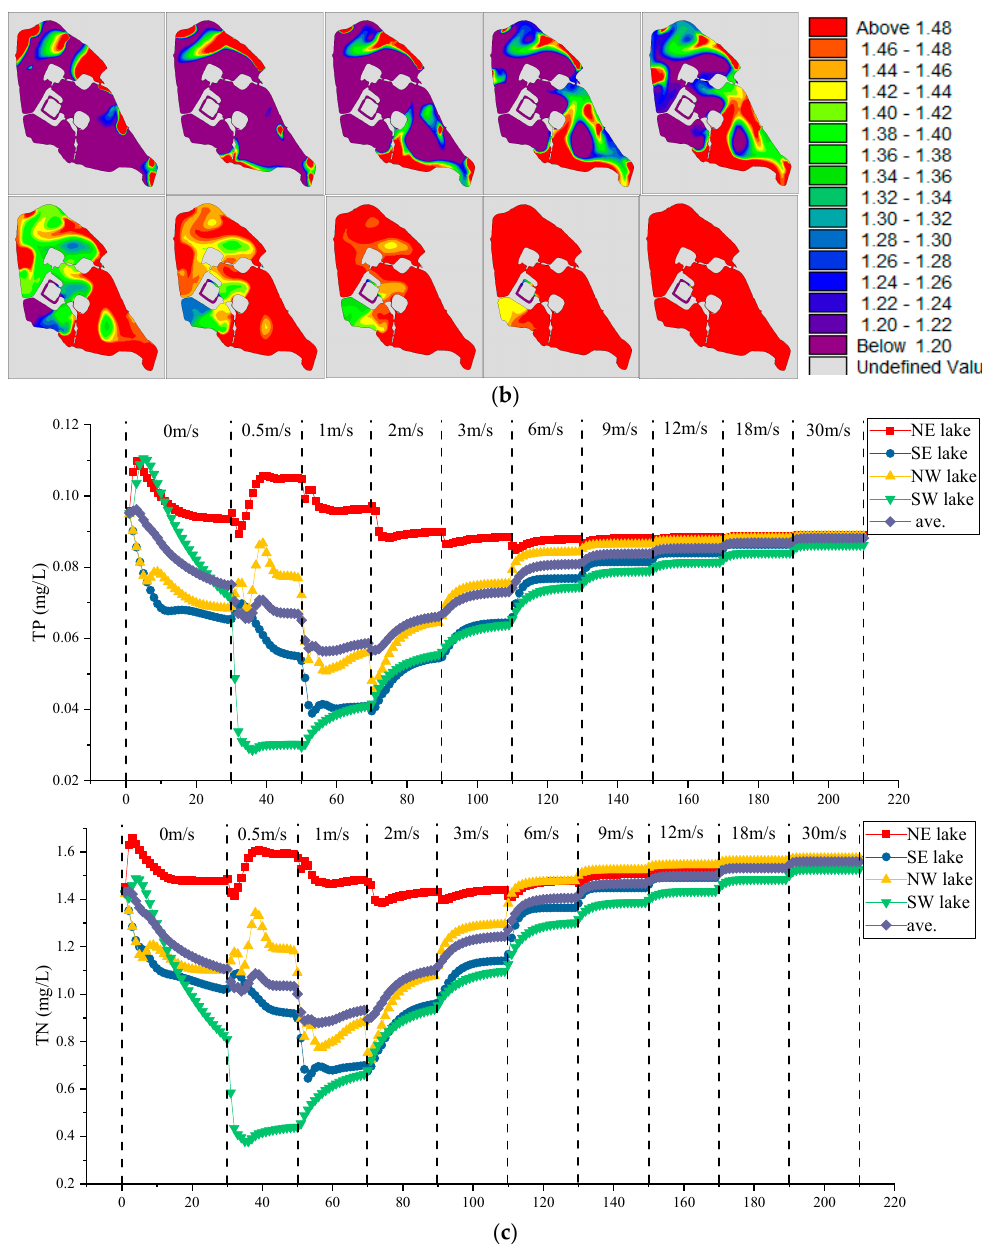
Figure 17. ( a , b ) are the concentration distribution of TP(total phosphorus) and TN(total nitrogen) under different speed of wind. From left to right and from the first row to the second row, the wind speeds are: 0 m/s, 0.5 m/s, 1 m/s, 2 m/s, 3 m/s, 6 m/s, 9 m/s, 12 m/s, 18 m/s, 30 m/s; ( c ) shows the changes in water quality under different wind speeds for different lake districts in Xuanwu Lake.